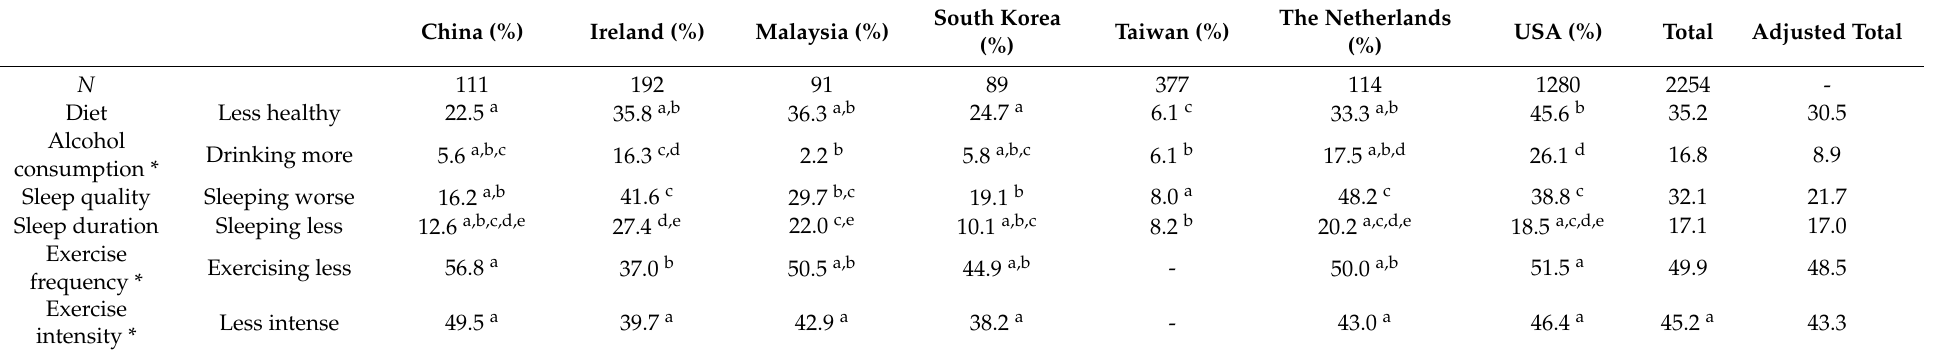
Table 5. Percentage of students reporting undesirable changes in health behaviors during the COVID-19 pandemic compared to before the